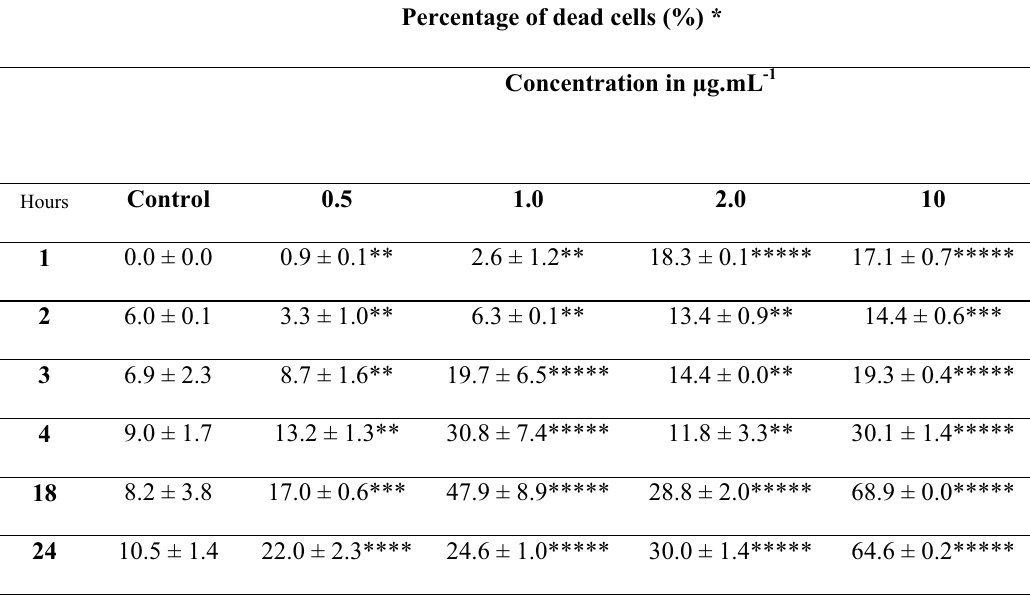
Percentage of cell death (%) after incubation of human lymphocytes (10 5 cells.mL -1 ) with saline (control) and